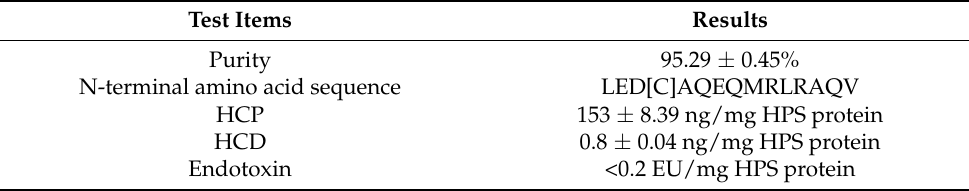
Table 1. Critical quality attributes of